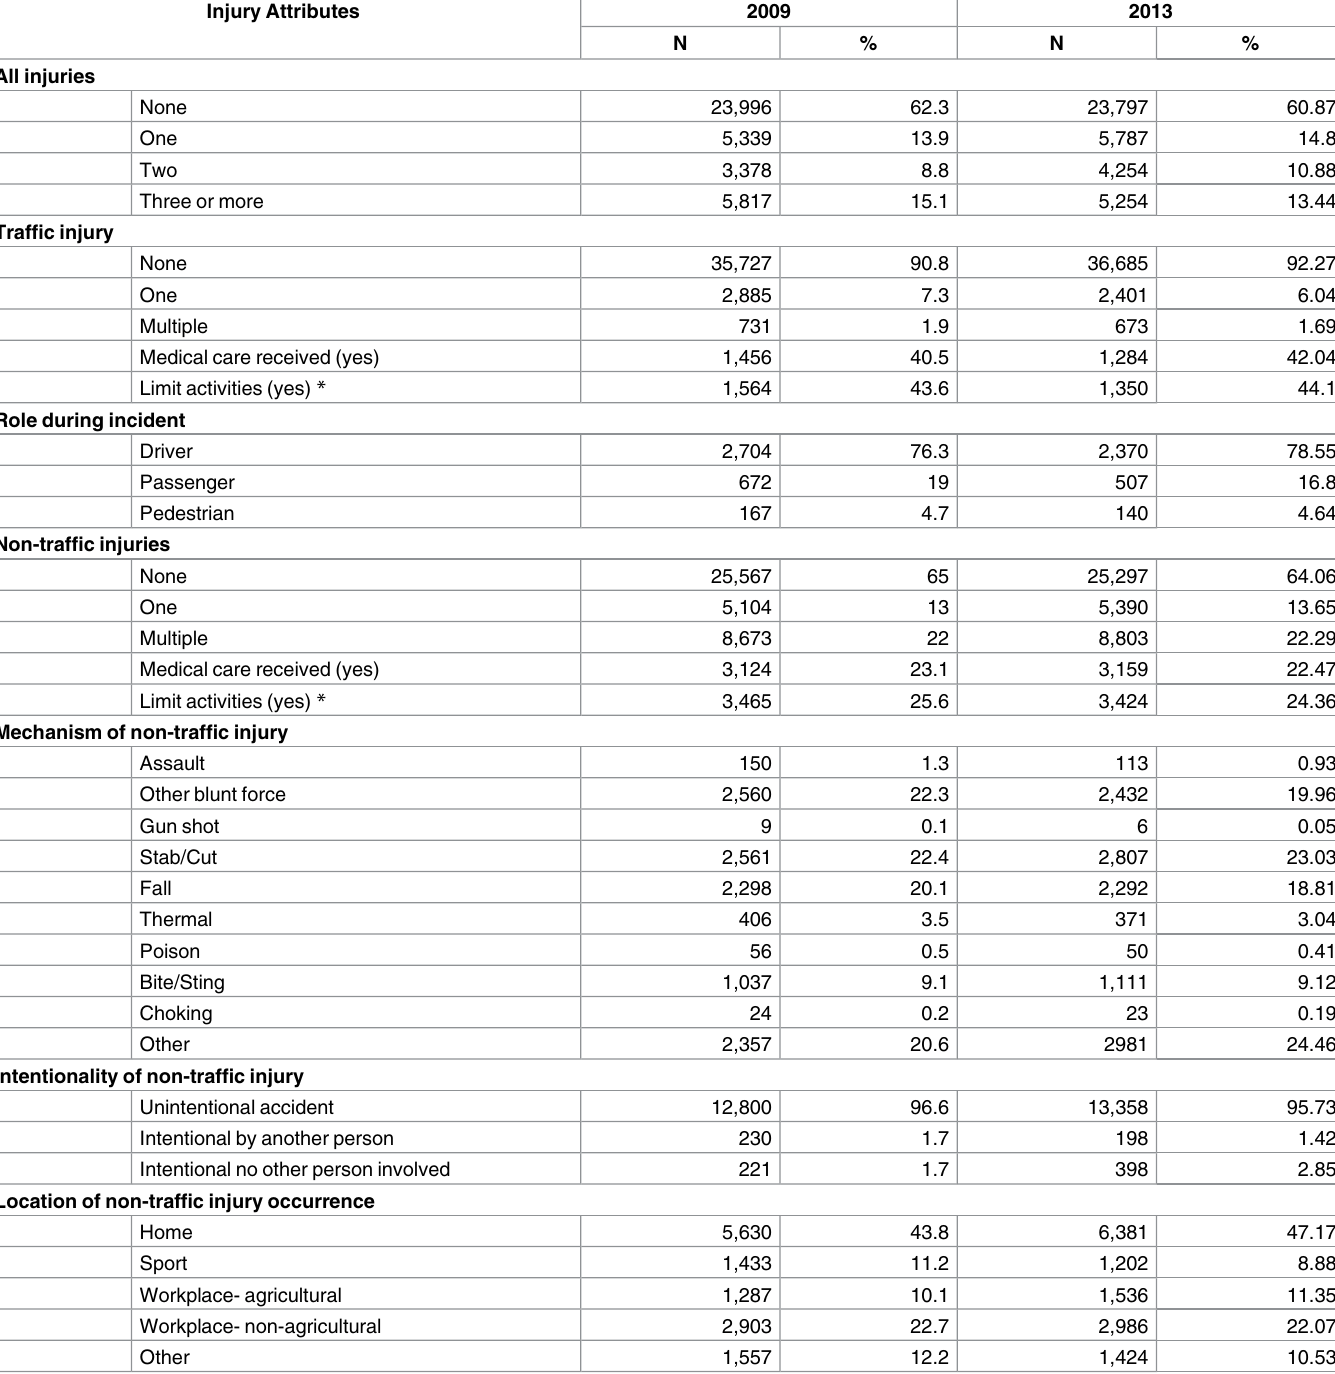
Table 2. Types of injuries, mechanisms and locations in the Thai cohort (2009 and 2013) (N =